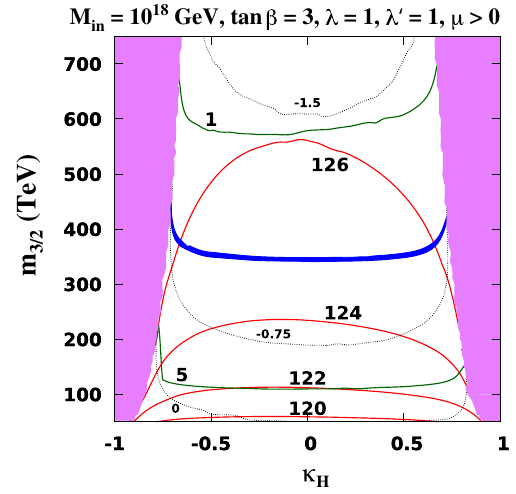
= 0, tan β = 3, Fig. 10 Example of a κ H - m 3 / 2 plane for κ (cid:6) = κ ¯ H M in = 10 18 GeV, λ = λ (cid:7) = 1, μ > 0. The red and green solid contours correspond tothe Higgs mass m h andthe proton lifetime τ( p → π 0 e + ) in units of GeV and 10 35 years, respectively. The blue shaded region shows the areas where the LSP abundance agrees to the observed dark matter density. The black dotted lines show the value of c whereas at larger κ ¯ it is simply a wino LSP with mass near H 3 TeV.